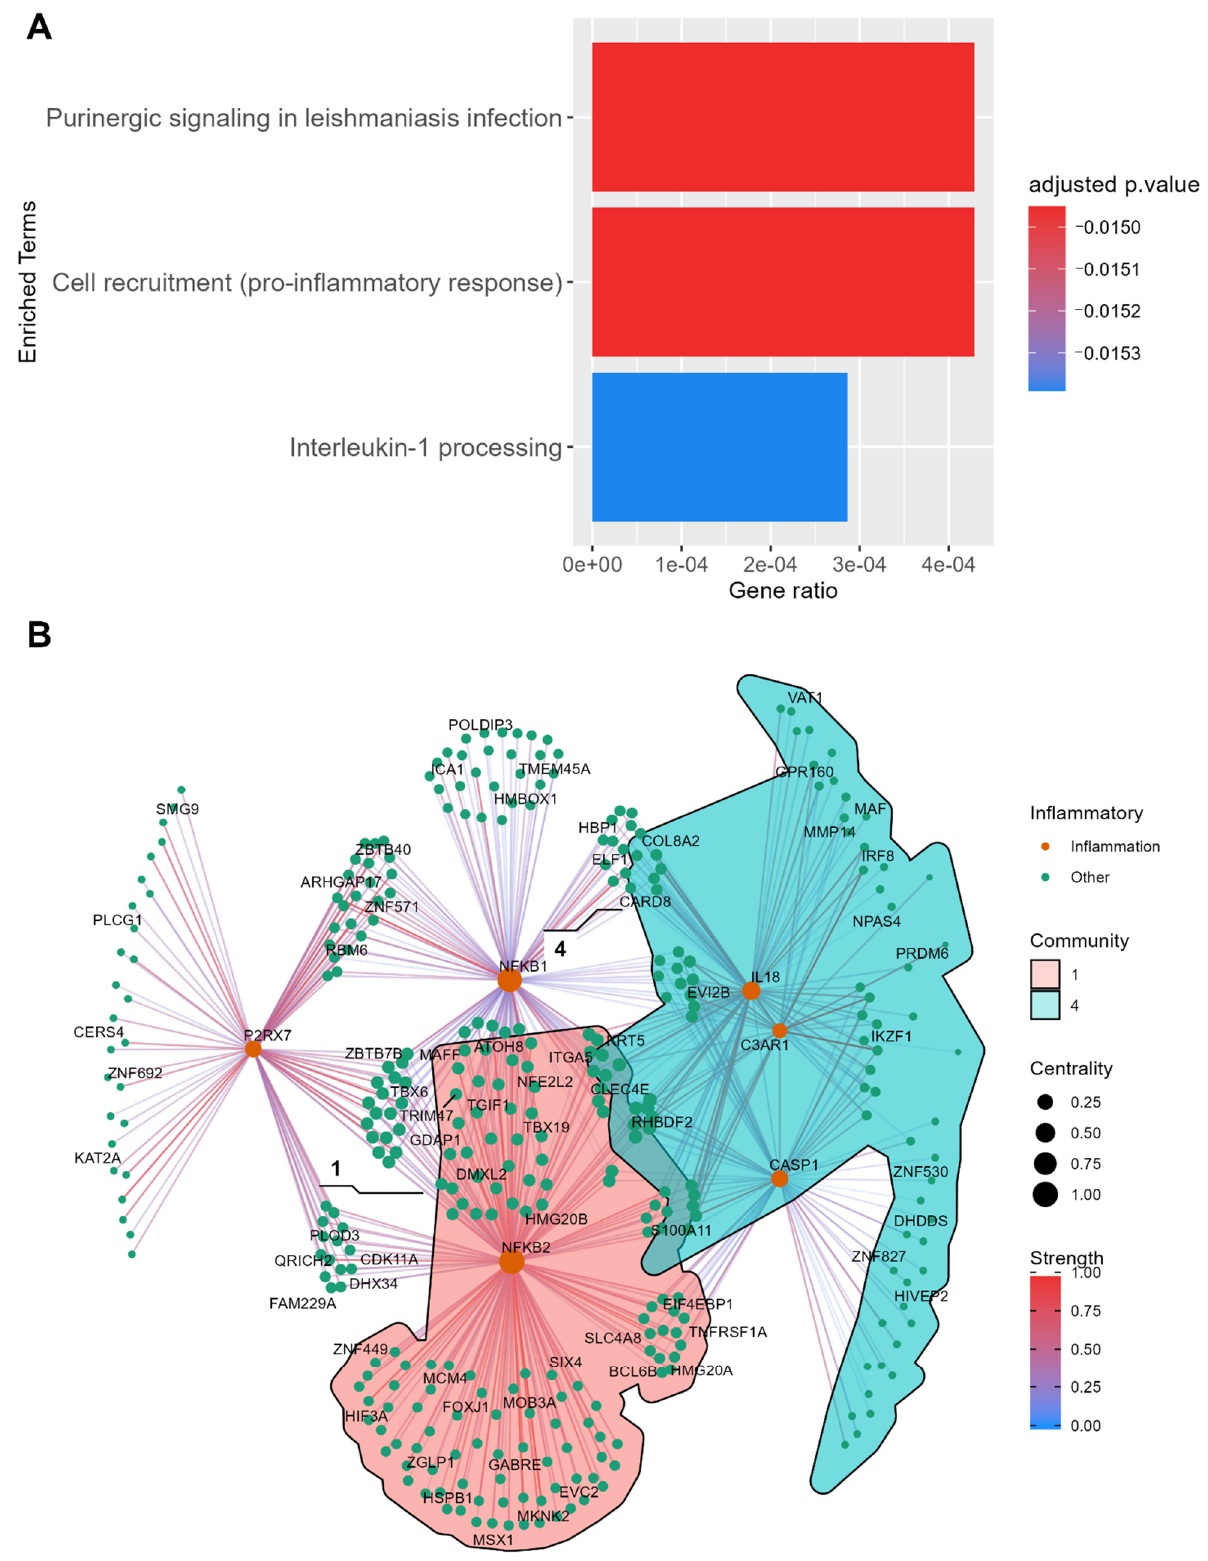
Figure 6. Investigation of the disease mechanism of PDC2, based on PDC2 vs. NC unique DEGs. ( A ) Enrichment analysis of DEGs shows that these genes map on inflammatory processes. ( B ) Gene network showing segregation in communities (only communities with significant PPI scores are colored). The network was built with the Kamada–Kawai layout, where each node is a gene and each edge is a PCIT value between